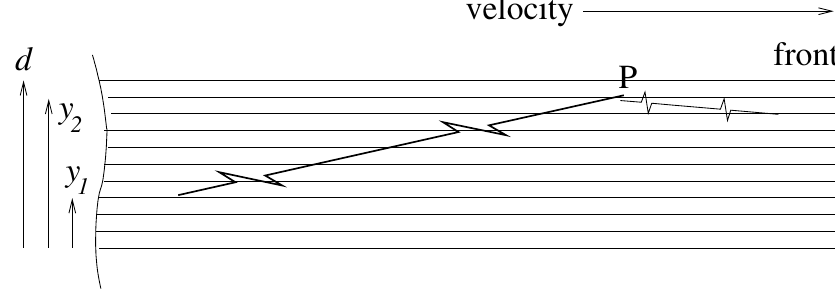
FIG. 2. Configuration used to calculate the self-force of a moving ribbon of charge. For subribbons transversely close, the point P is largely influenced by points further forward in the bunch that take advantage of their earlier arrival to ‘‘send signals back.’’ Subribbons transversely farther away from the point P can be influential only by sending a signal from far enough back for the slight c > v signal speed advantage to make up for the extra signal path